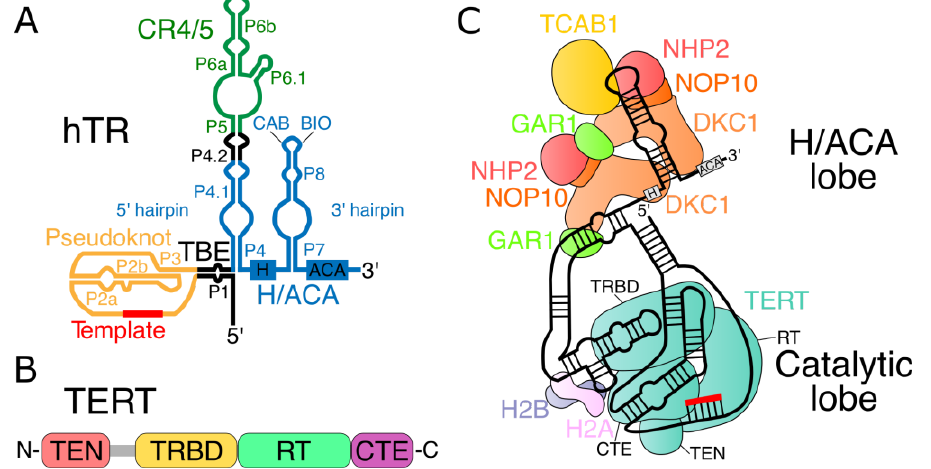
Figure 3. Scheme of hTR and hTERT structures and human telomerase holoenzyme. ( A ) Secondary structure of human telomerase RNA (hTR). CR4/5—conserved regions 4 and 5; TBE—template boundary element; H/ACA—H and ACA boxes; CAB—Cajal body box; BIO—biogenesis-promoting box. Pseudoknot, template, 5′ and 3′ hairpins of H/ACA domain, and P1, P2a, P2b, P3, P4, P4.1, P4.2, P5, P6a, P6b, P6.1, P7, and P8 elements are labeled. ( B ) Domain structure of telomerase